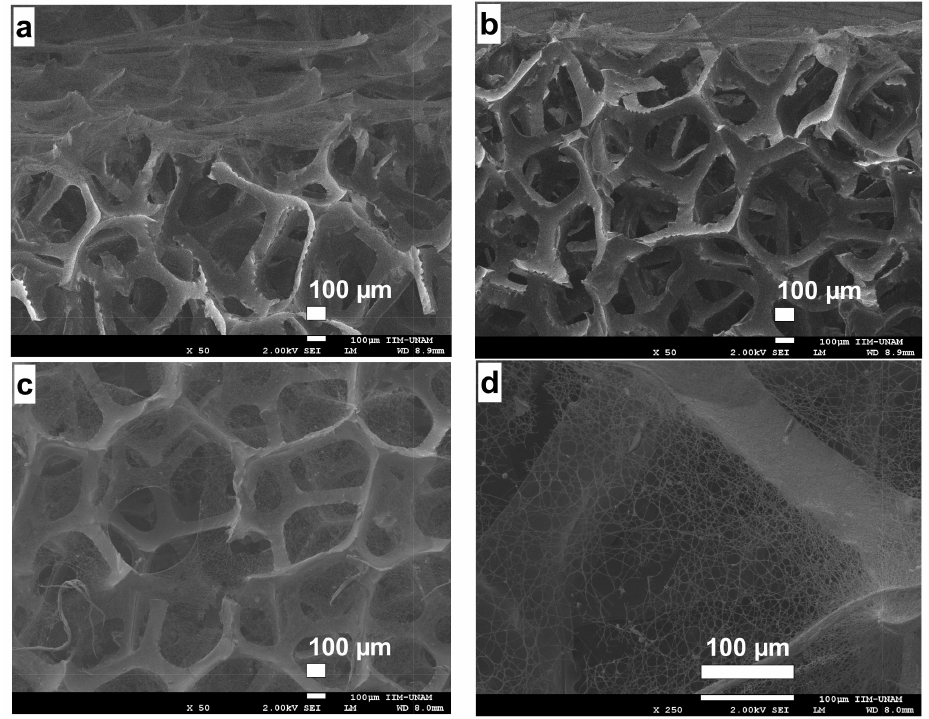
Figure 9. SEM micrographs of electrospun nanofibers deposited on RVC (90 min): ( a , b ) cross sections; ( c , d ) top-view